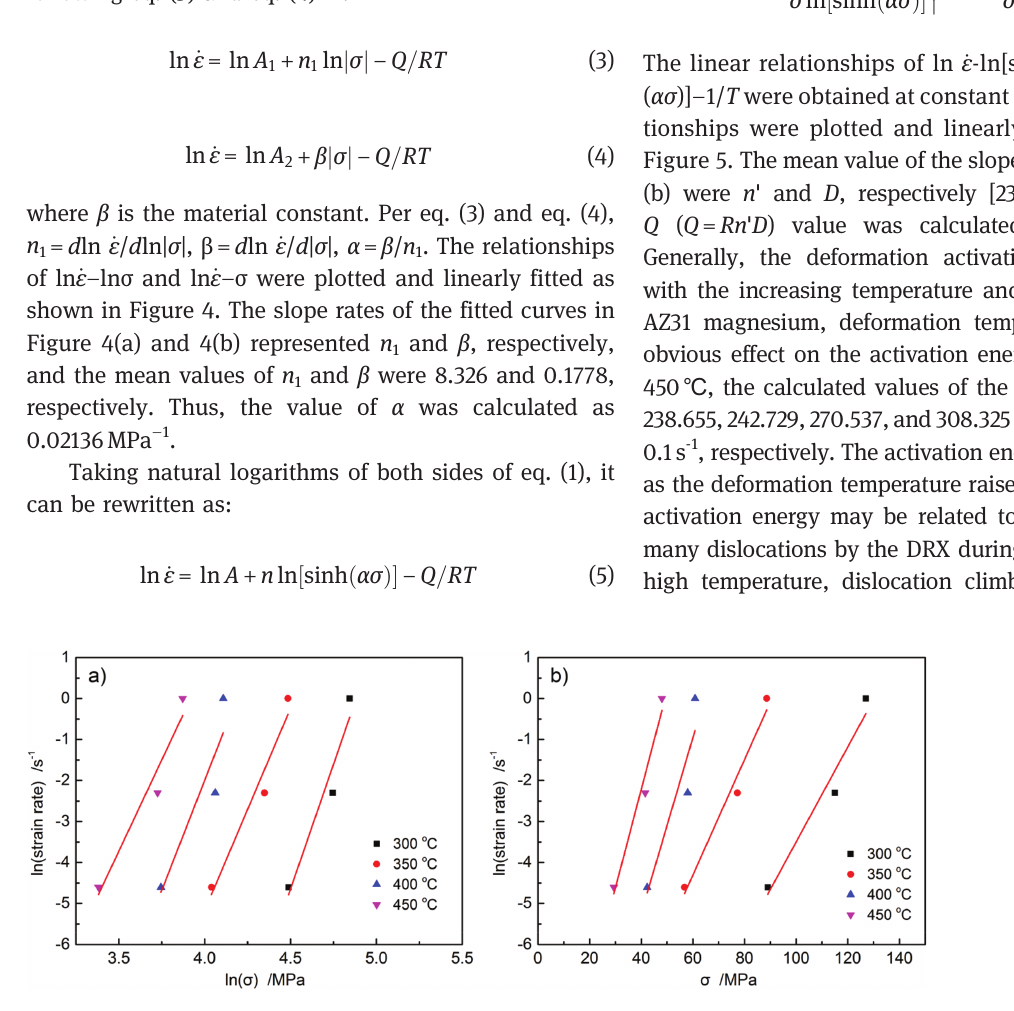
Figure 4: Relationships between ln _ ε and (a) ln σ and (b) σ .